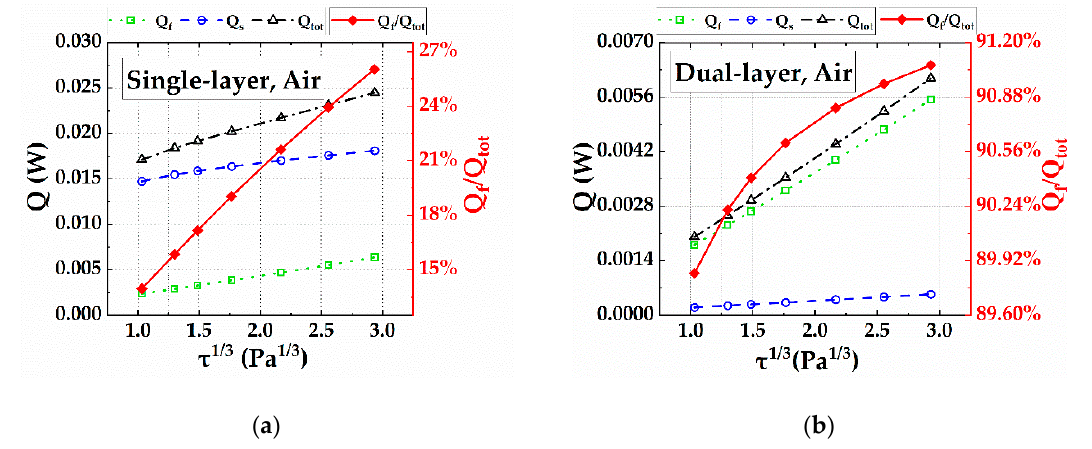
Figure 9. The simulation results of the heat conduction power to the substrate Q s , the heat transfer